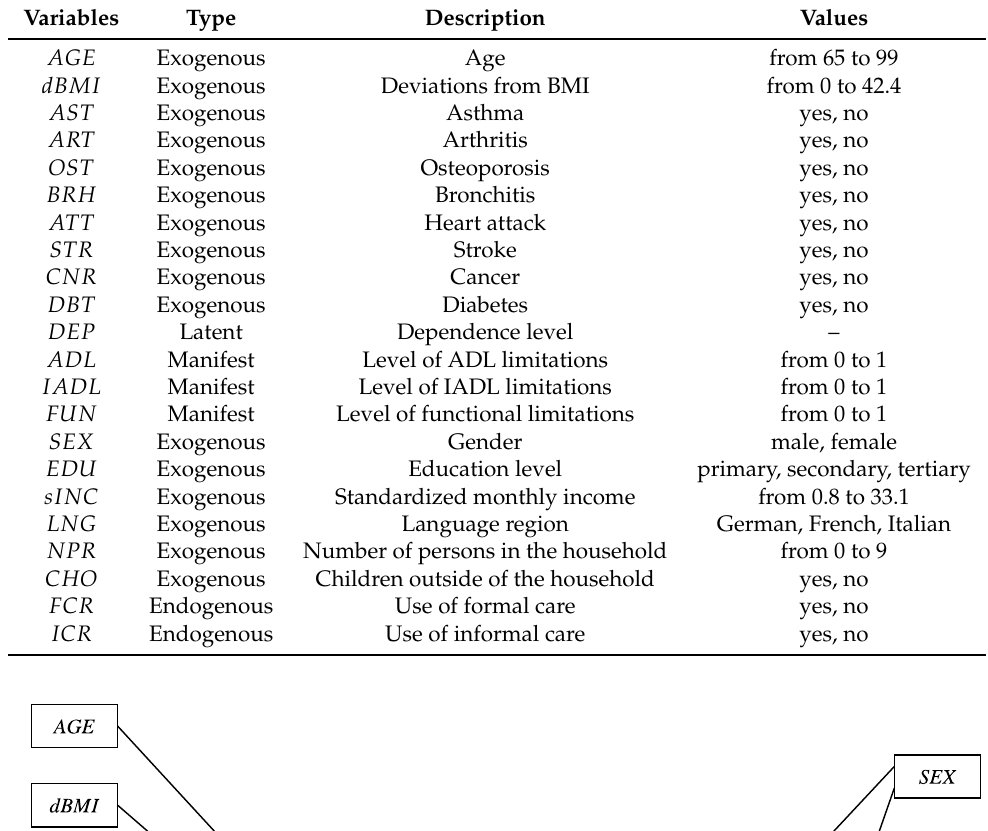
Table 5. Description of the variables used in the model.